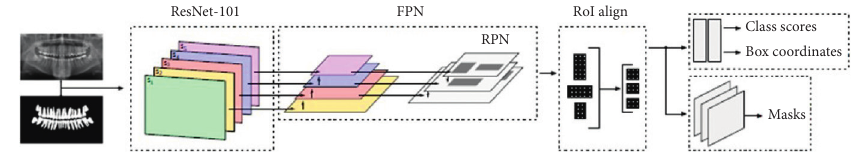
Figure 8: Training process of the segmentation system [63].